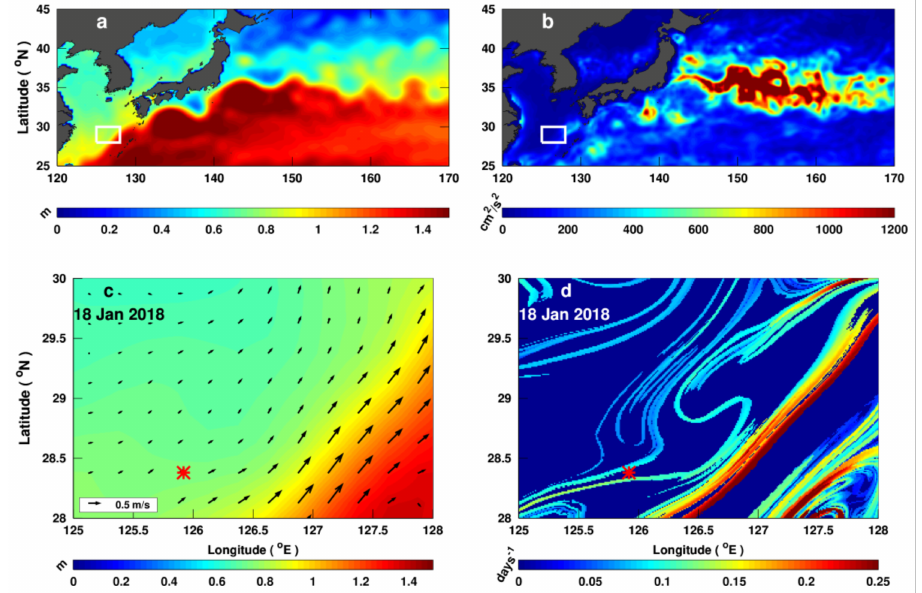
Figure 2. The region of the oil spill accident in the East China Sea, in the Northwest Pacific ocean. Panels ( a , b ) illustrate the 2018 mean sea surface height (in m) and the 2018 mean eddy kinetic energy (in cm 2 /s 2 ), respectively. The white rectangle shows the East China sea oil spill area that is reported in panels ( c , d ). The sea surface heights (color, in m) and the derived current velocities (arrows, in m/s) in the smaller scaled region of the East China Sea oil spill on the 18th of January 2018 are mapped in panel ( c ). The altimetry-derived finite-size Lyapunov exponent (in days − 1 ) for the same date is computed backward in time ( d